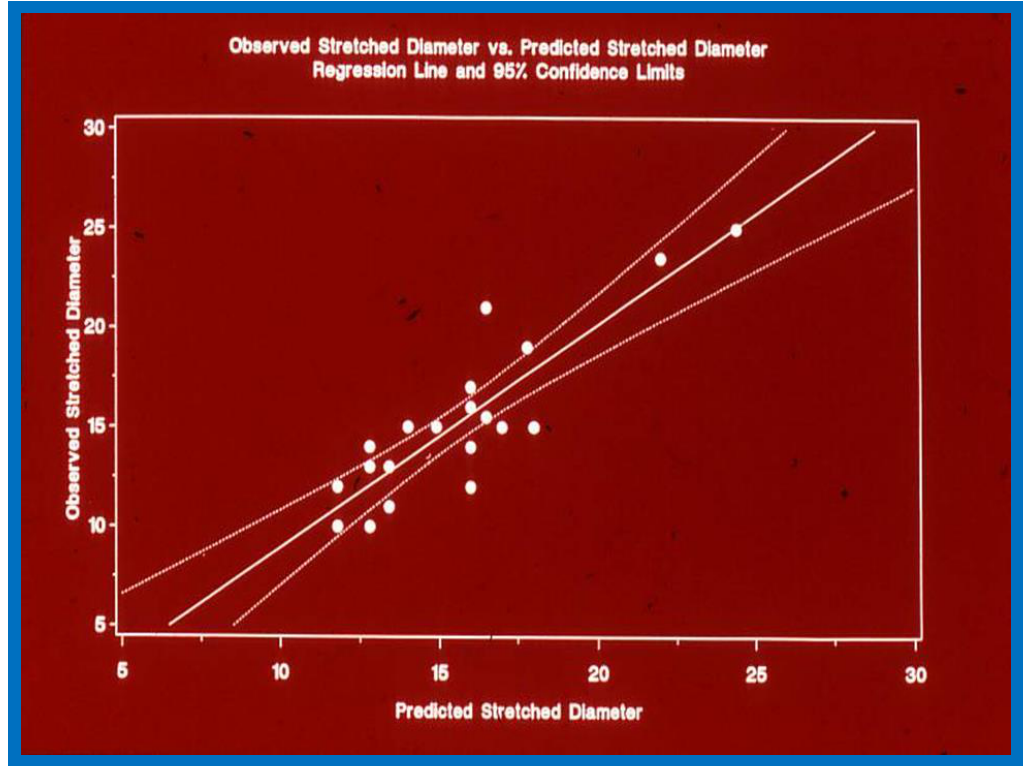
Figure 4. Plot similar to Figures 1–3 showing the relationship of predicted atrial septal defect (ASD) diameter by formula (1.05 × echo size in millimeters) + 5.49, with measured stretched size of the atrial septal defect: Note significant ( p < 0.001) correlation with an r value of 0.9. Reproduced from Rao P.S., et al. [3].